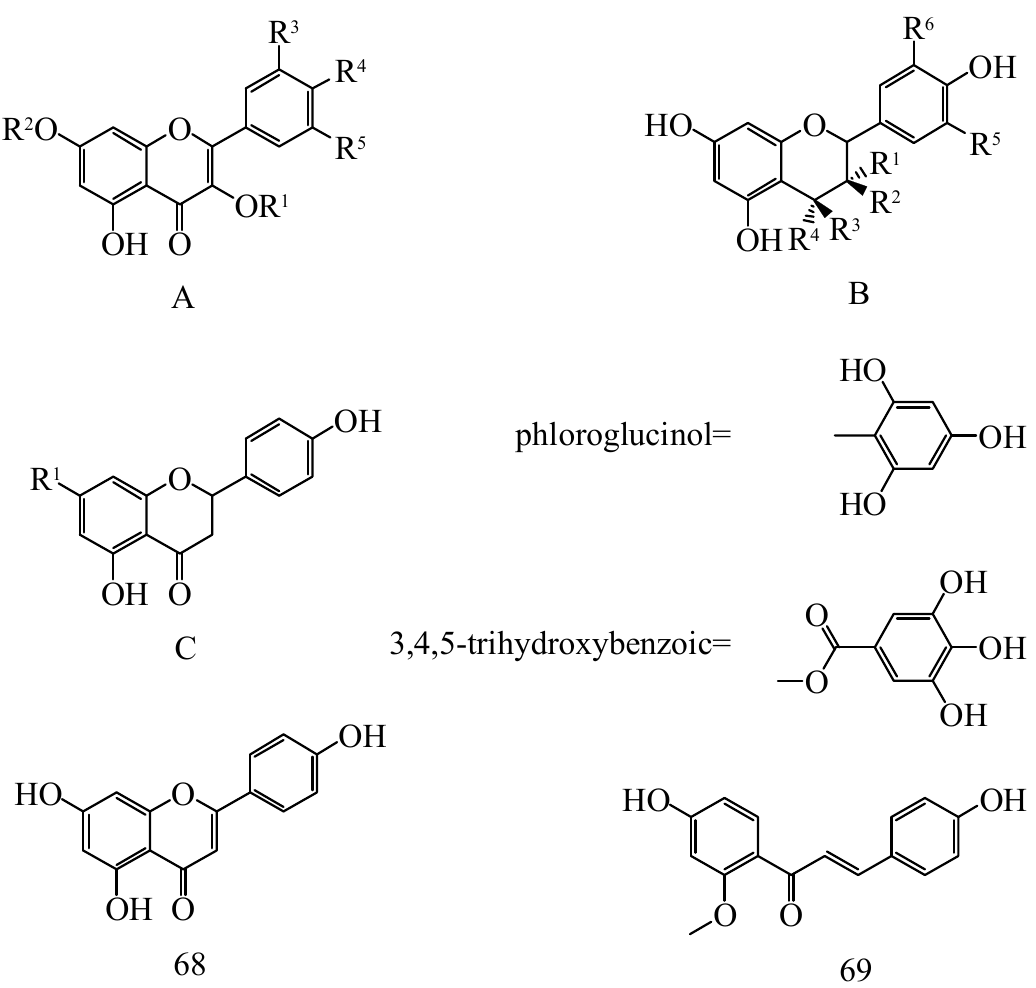
Figure 3. Chemical structures of flavonoids from Hippophae species.